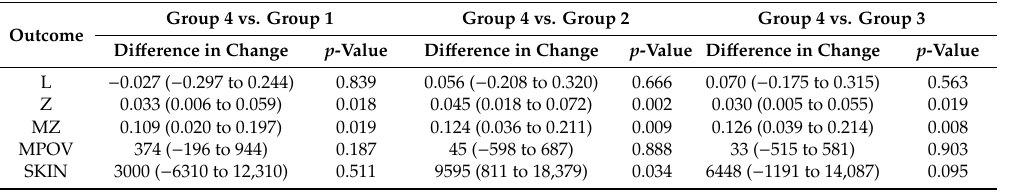
Table 4. E ff ect of the diacetate formulation on serum and tissue response compared to the other formulations 1